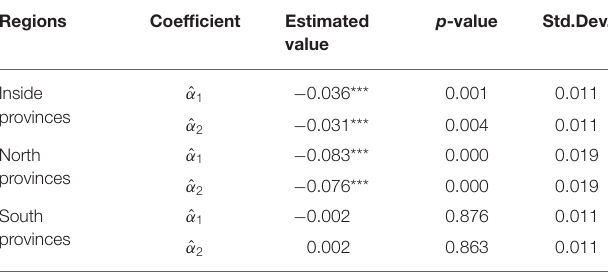
TABLE 4 | Estimated coefficients of Urbanization and Population